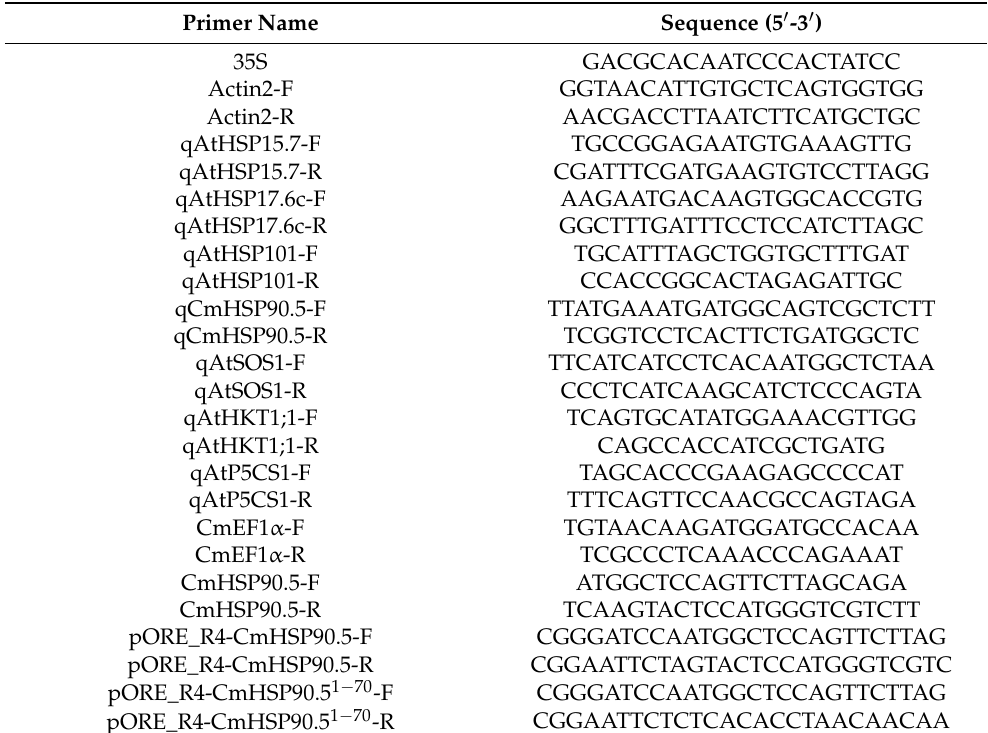
Table 1. Primer names and sequences used in this